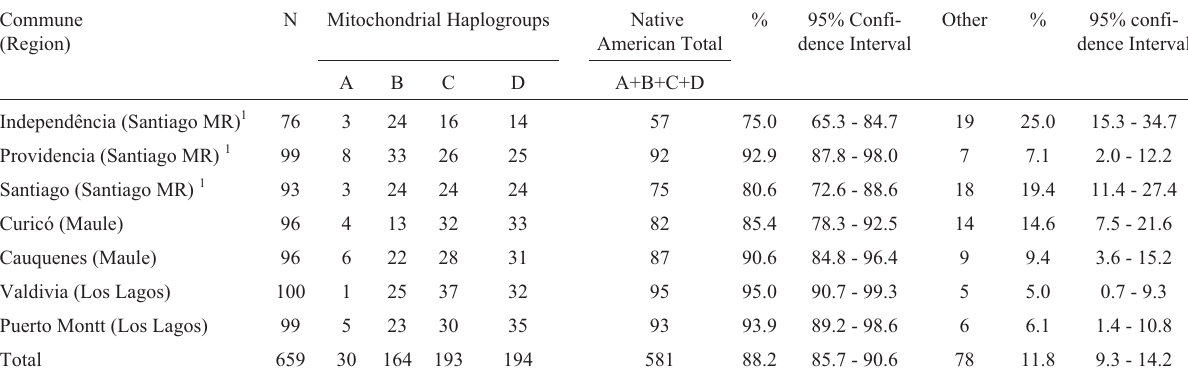
Table 2 - Native American mtDNA haplogroups in the seven Chilean communes. Commune